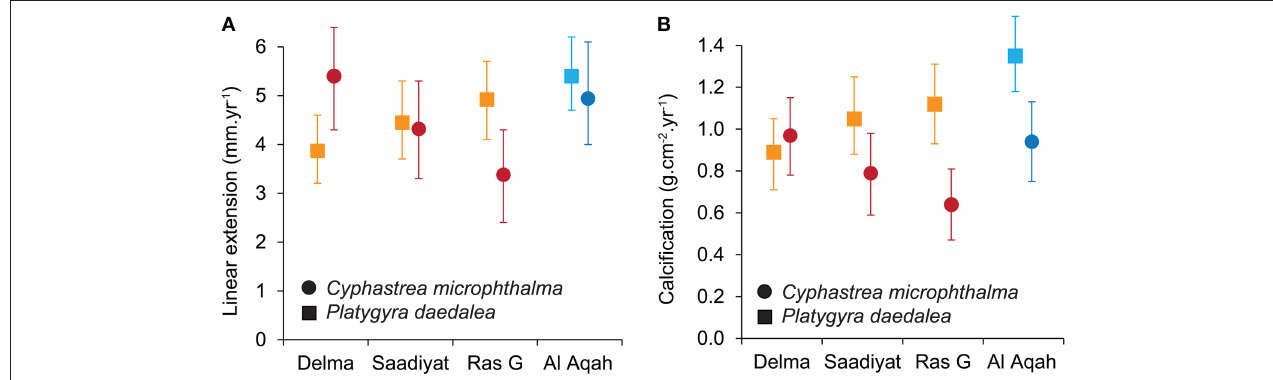
FIGURE 3 | Site variation in linear extension (A) and calcification (B) for the corals Cyphastrea microphthalma and Platygyra daedalea in the Persian Gulf (red/orange) and Oman Sea (dark blue/light blue). Values are means and 95% highest posterior density (HPD) intervals from model outputs.